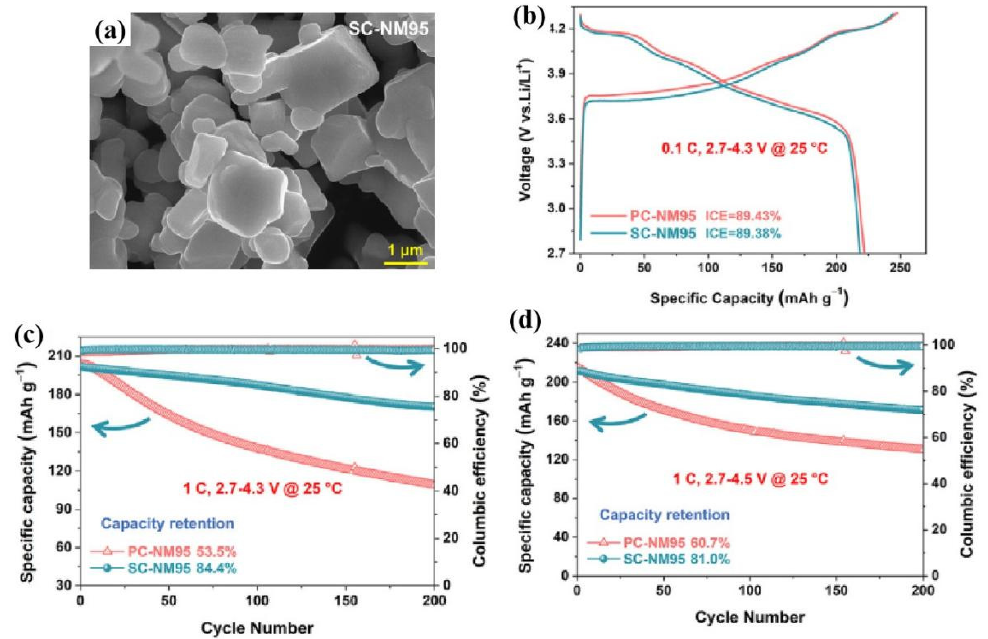
Figure 5. Research content reproduced from Ref. [237]: ( a ) SEM image of fresh SC-NM95 materials; ( b ) the first discharge/charge curves, and the cycling performance at difficult cut-off voltage of ( c ) 4.3 V and ( d ) 4.5 V of comparison between SC-NM95 and PC-NM95 materials, Copyright 2022, Elsevier.